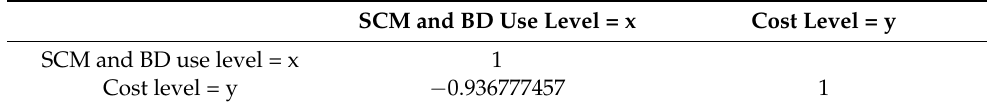
Table 6. Pearson correlation (SCM and BD use level and cost level).